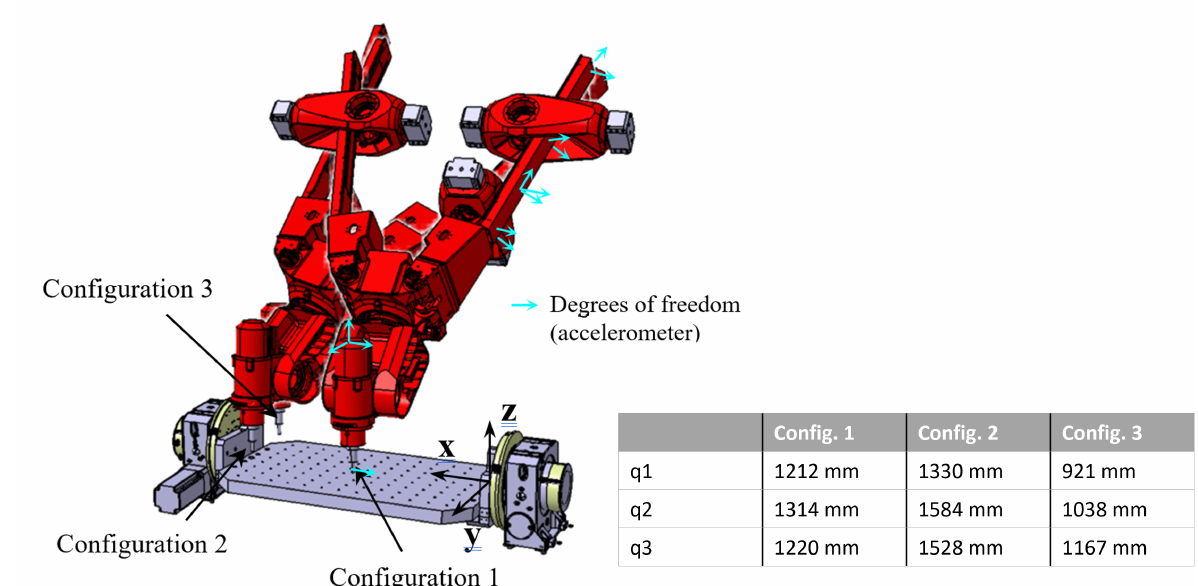
Figure 14. Configuration of the Tripteor X7 for the experimental